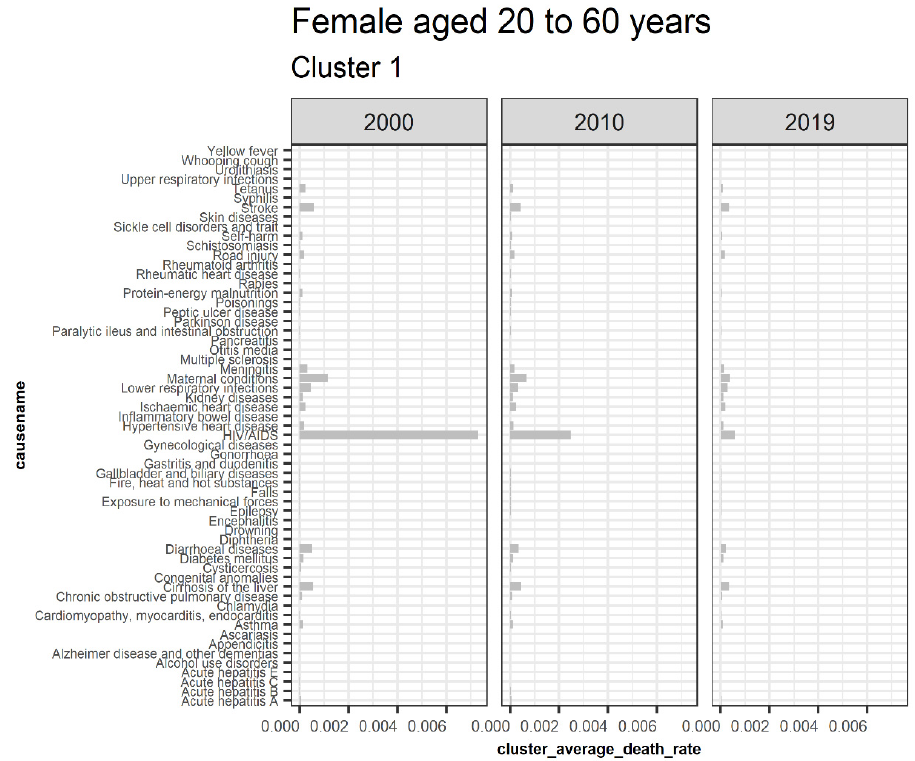
Figure 8. Declining trend of the causes of death among younger females in cluster 1 for 2000, 2010, and 2019.